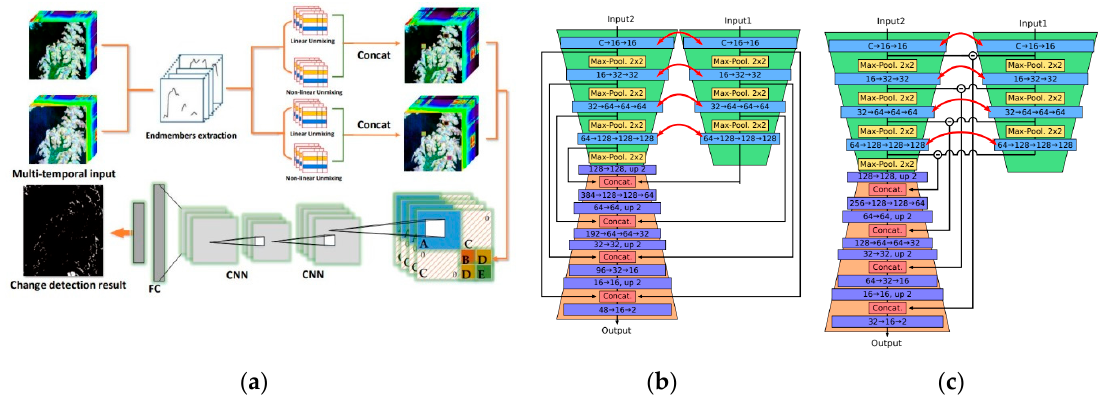
Figure 6. Overview of the three state-of-the-art CD frameworks based on deep learning. ( a ) General End-to-end Two-dimensional CNN Framework (GETNET) [29], ( b ) Siamese-concatenate network [44], and ( c ) Siamese-differencing network [44].